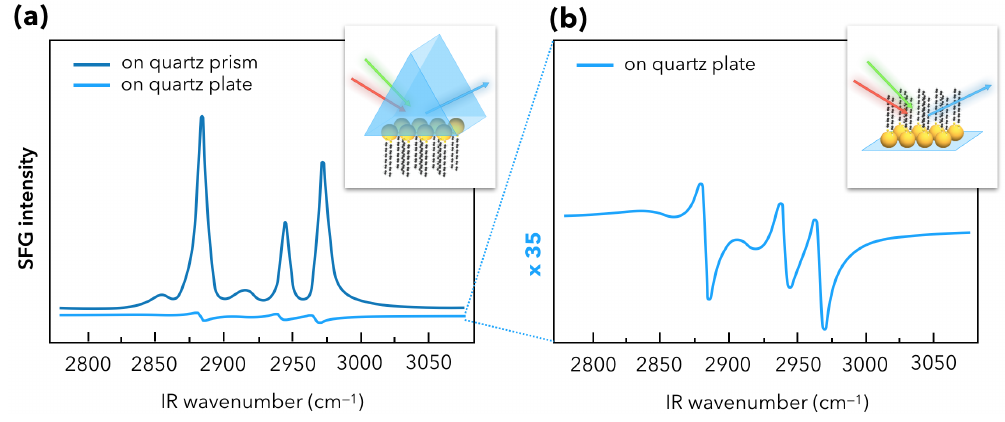
Figure 7. ( a ) SFG spectra of DDT molecules grafted on quartz surface (prism) in a total internal reflection SFG (TIR-SFG) configuration compared with the classical SFG reflection configuration on a quartz surface (plate). ( b ) Zoom of the SFG spectrum of the plate surface, illustrating the great differences in the respective spectral shapes and intensities. It is worth noting that the SFG spectra of the methyl (CH 3 ) vibration modes pointing out from the probed surface are strongly enhanced in the TIR-SFG configuration (35 times higher). The latter show that DDT molecules adopt a well-organized conformational order inside the self-assembled monolayer (SAM). Picture adapted from reference